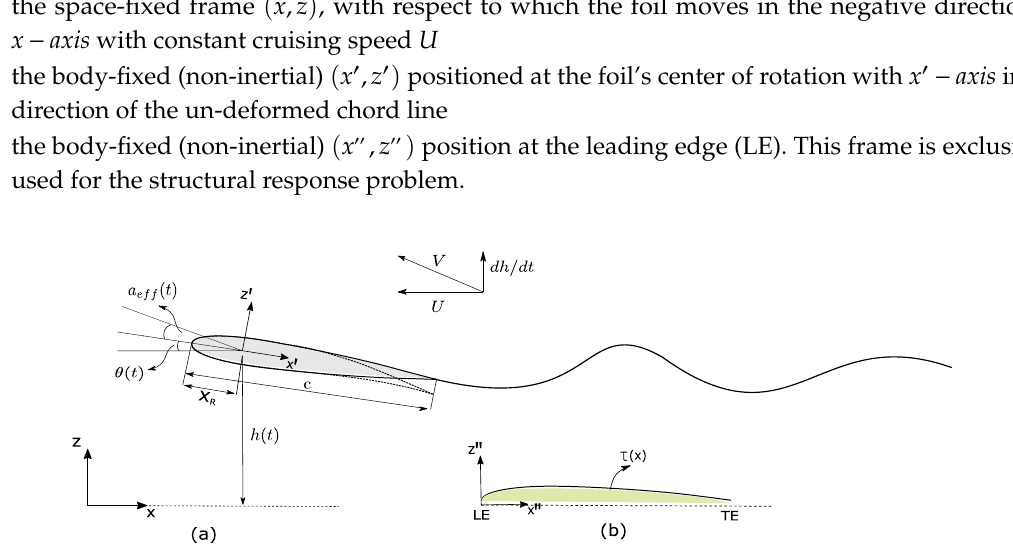
Figure 1. Basic notation: ( a ) flexible flapping-foil kinematics with respect to a space-fixed Cartesian coordinate system ( x , z ) and ( b ) thickness profile in a body-fixed cartesian coordinate system ( x ’’, z ’’).